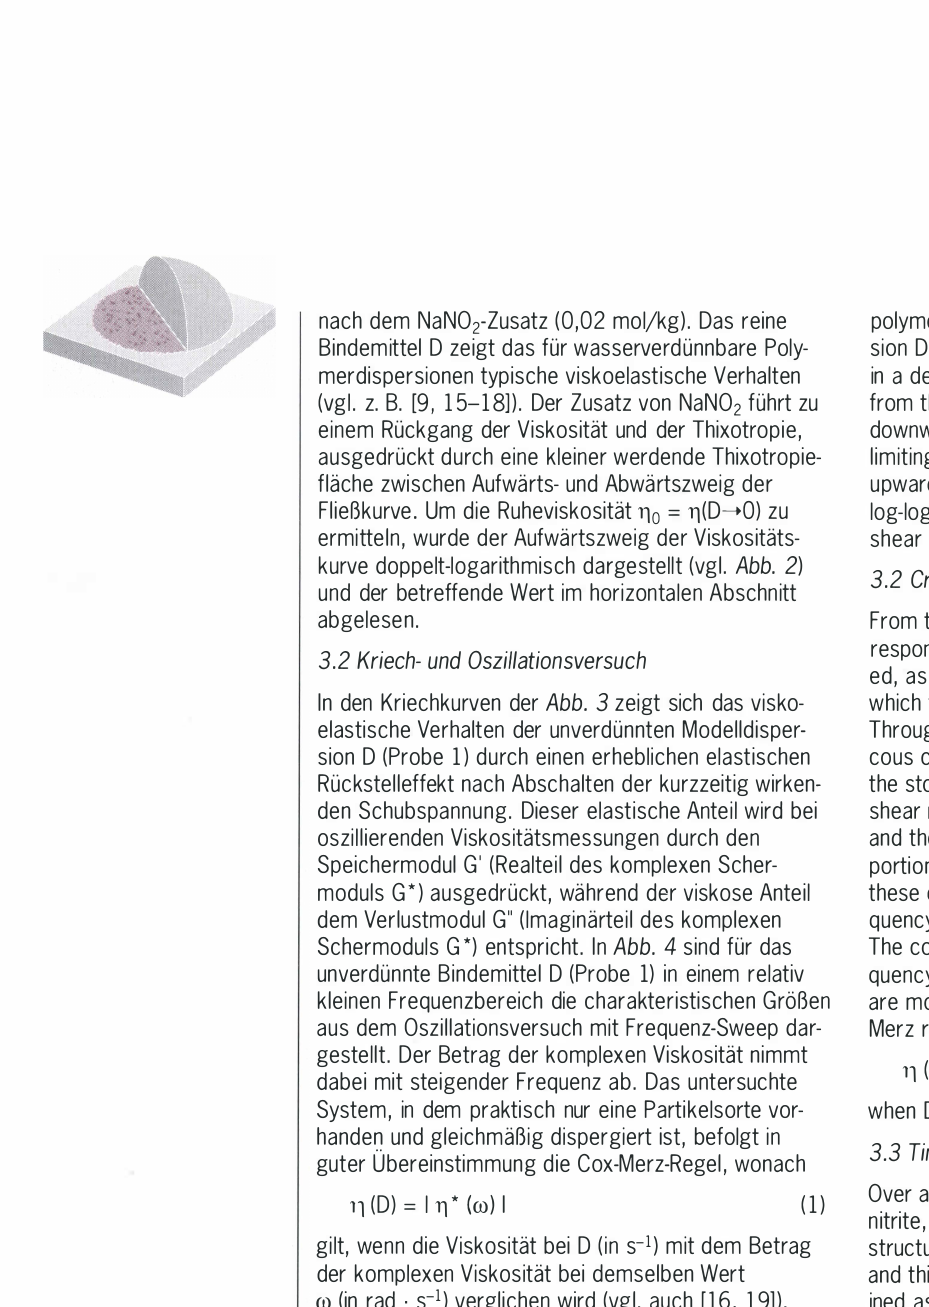
Fig. 3: Creep curves for model dispersion D (sample 1} at 25